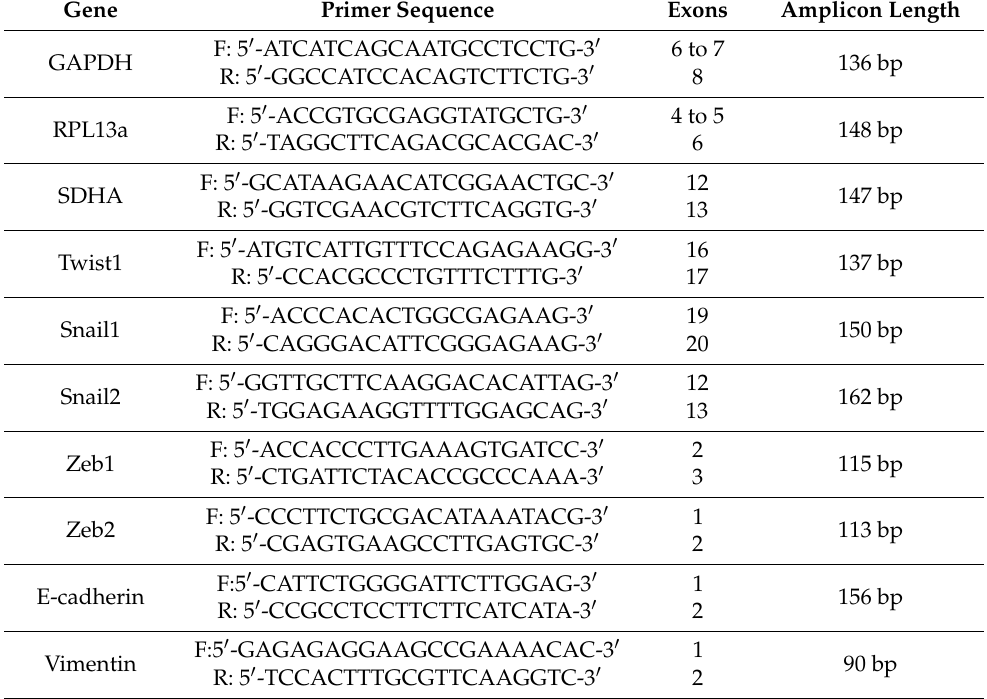
Table 1. Sequences, genomic positions, and amplicon sizes of the primers used in qRT-PCR for the target and reference genes. GAPDH, glyceraldehyde-3-phosphate dehydrogenase; RPL13a, ribosomal protein L13a; SDHA, succinate dehydrogenase complex, subunit A; Twist1, twist basic helix-loop- helix transcription factor 1; Snail1, snail family zinc finger 1; Snail2, snail family zinc finger 2; Zeb1, zinc finger E-box binding homeobox 1; Zeb2, zinc finger E-box-binding homeobox 2. Primer